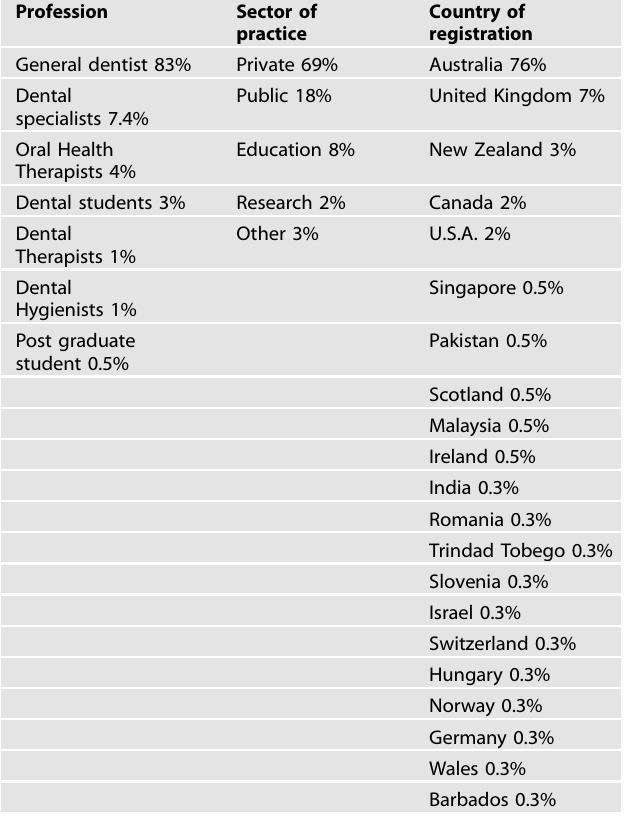
Table 1. Demographics of survey